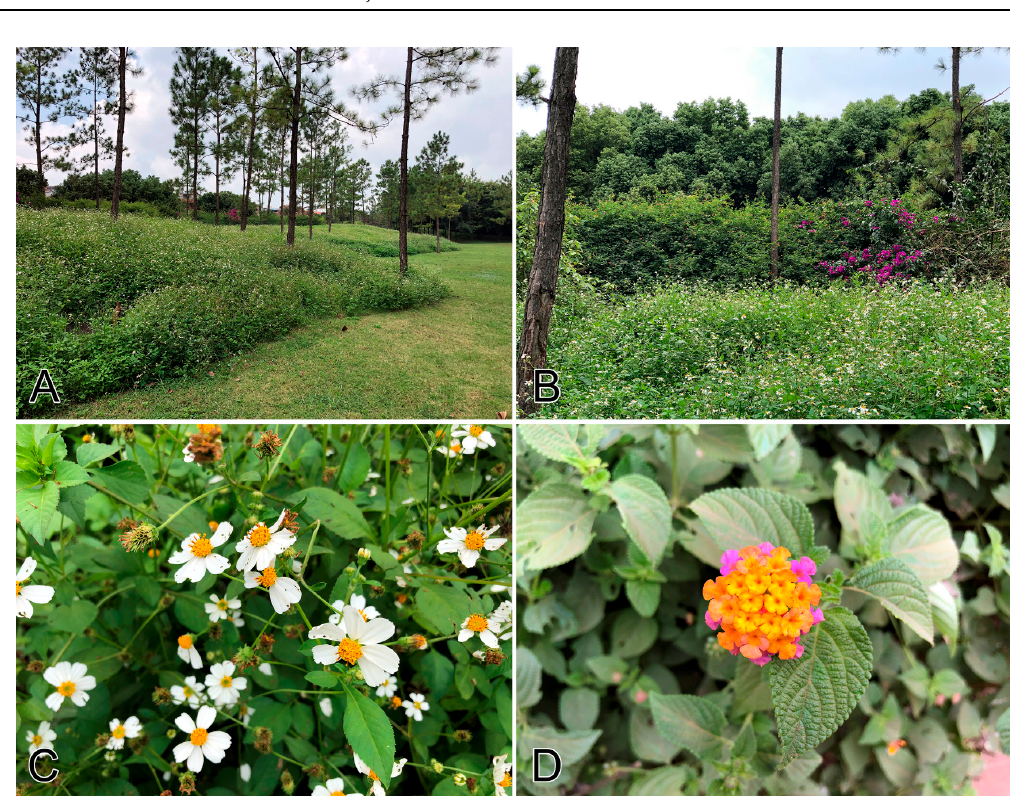
Figure 2. Unmanaged green space in the Huquan Park of Mile (a very young city), Yunnan Province, Southwest China. ( A ): boundary between managed lawn and unmanaged green space; ( B ): plant community inside the unmanaged green space; ( C ): dominant nectar source Bidens sp.; ( D ): nectar source Lantana camara along the